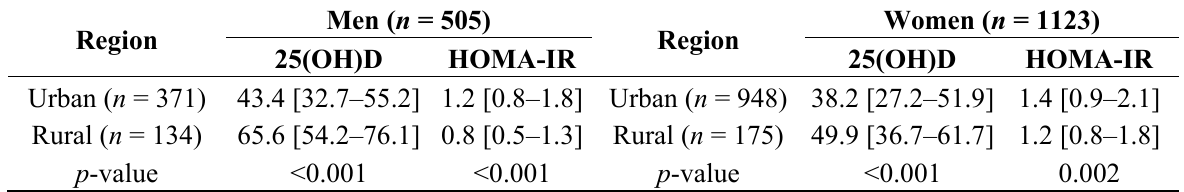
Table 4. Serum 25(OH)D and HOMA-IR according to residential area.